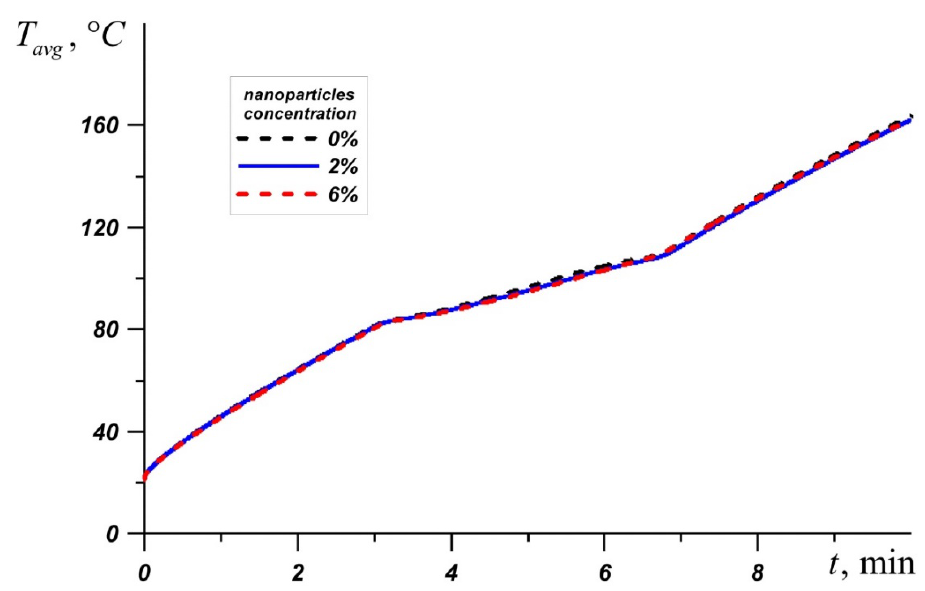
Figure 8. Average source temperature for RT-80 at different nanoparticle concentrations.